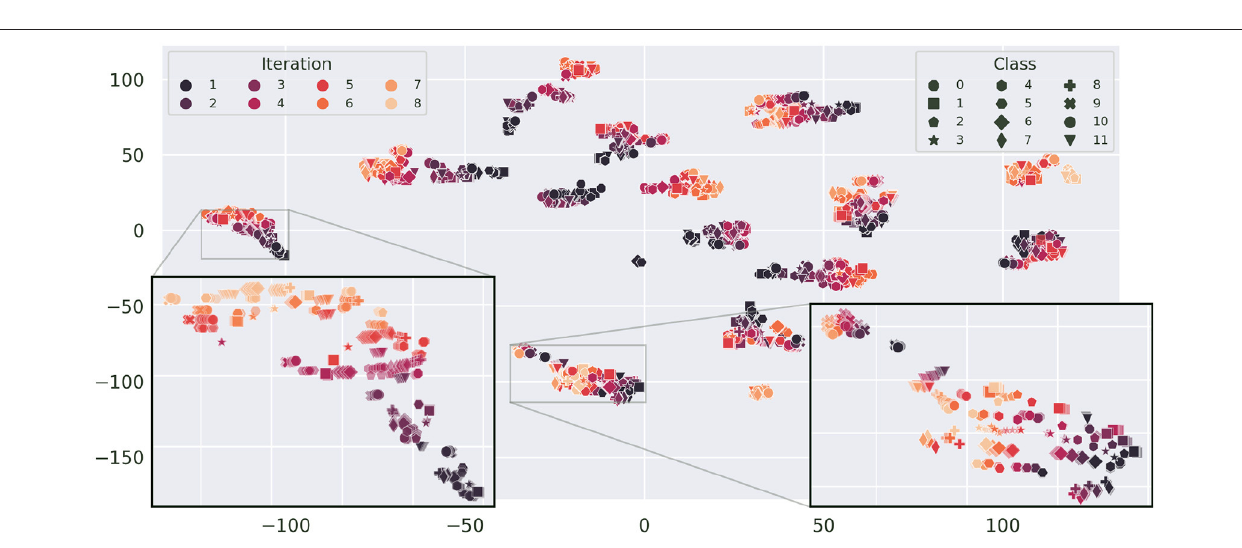
FIGURE 9 | t-SNE projection of Figure 8 colorized by iteration (perplexity increased to 100). Here, classes are indicated by distinct markers. As subject F has a single iteration for each session only, the plot is limited to subjects A–E. The gradient from dark to light, visible in most clusters, illustrates the sample drift with increasing number of iterations. Sessions D1 (left) and E8 (right) are zoomed in upon for closer